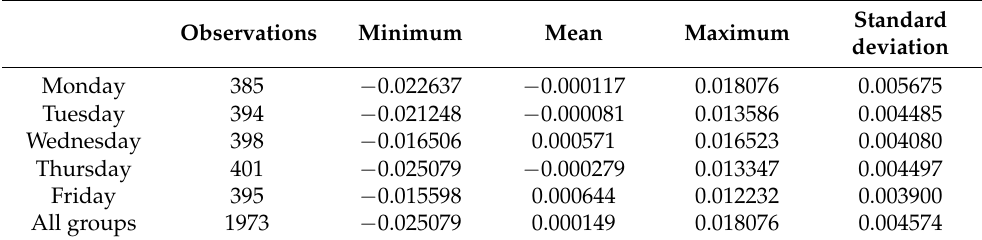
Table 4. Summary statistics of daily returns for the entire